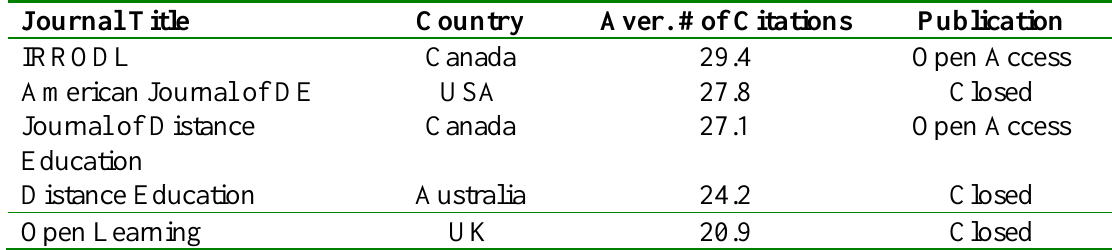
Table 1. Open Access vs. Closed Access distance education journals’